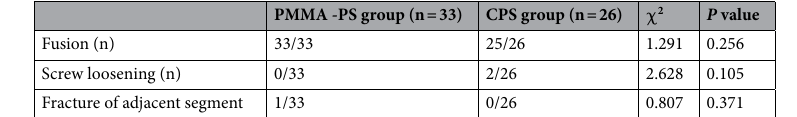
Table 4. The fusion status and postoperative complications of the two groups.